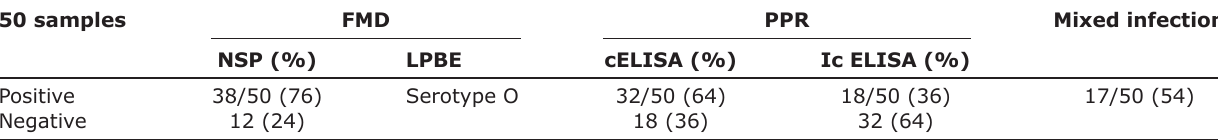
Table-1: Results of the tested samples with four different ELISA types for the detection of FMD antibodies and serotyping in addition to the detection of both PPR antibodies and antigen. 50 samples